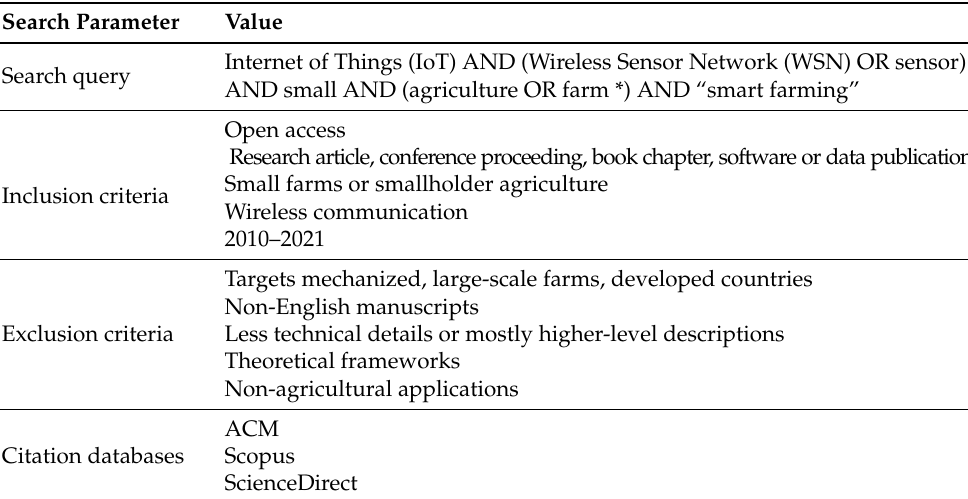
Table 1. Systematic search parameters to identify relevant papers for review. * is a wildcard of zero or more search characters and can take ing, er,